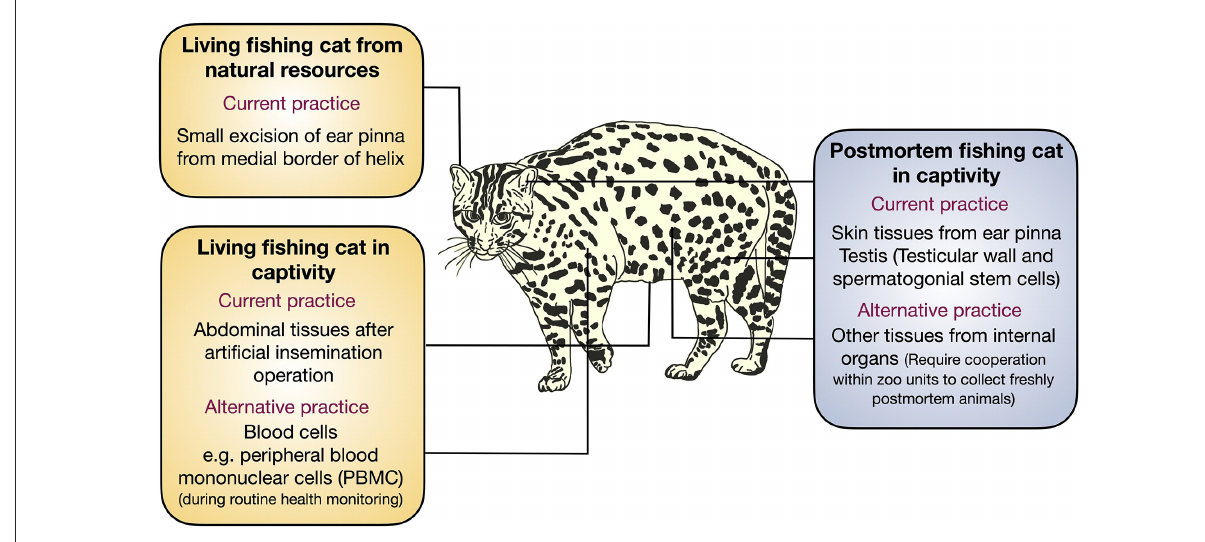
FIGURE7 Tissue collection from fishing cat for conservation. Schematic illustration showing various sources of tissue collection for primary cell culture for cryopreservation in this study and suggesting the alternative sources for primary cells from the fishing cats.